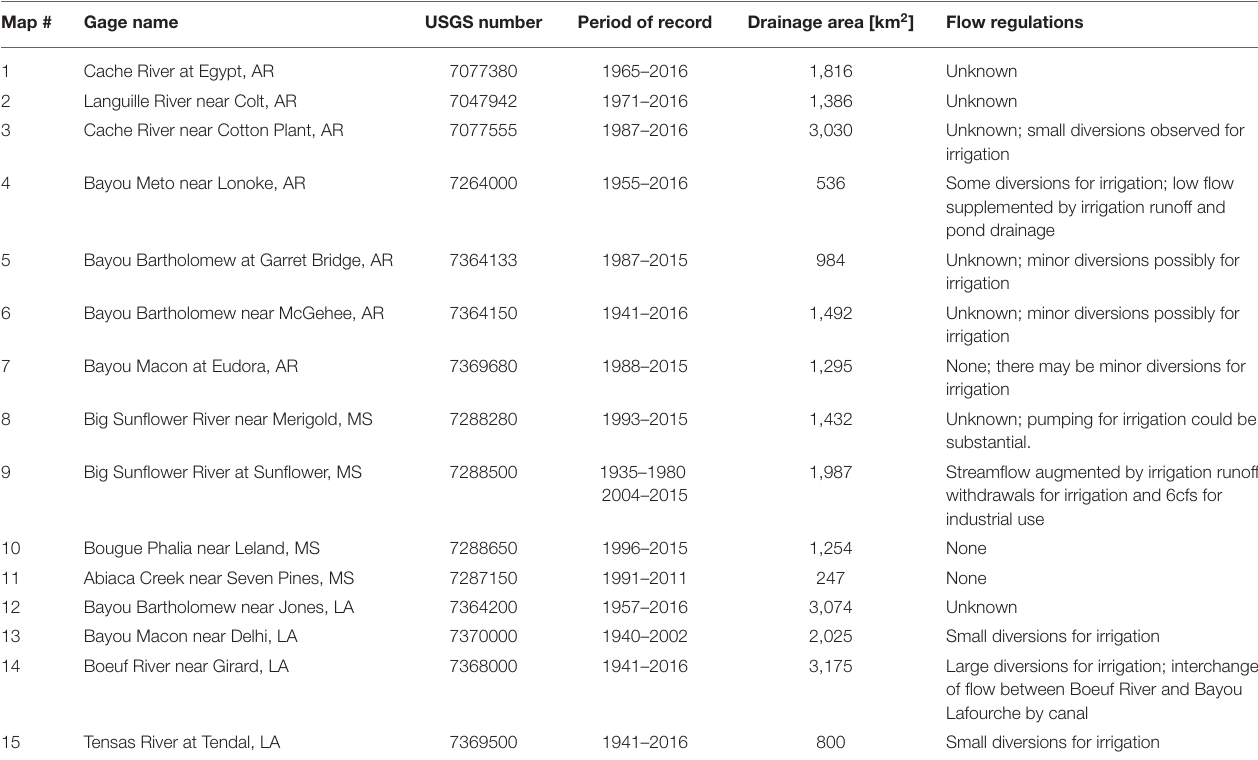
TABLE 1 | USGS gages utilized in study, including period of record, drainage area, and any known flow regulations from the USGS StreamStats program, listed in order from north to south (U.S. Geological Survey, 2016).